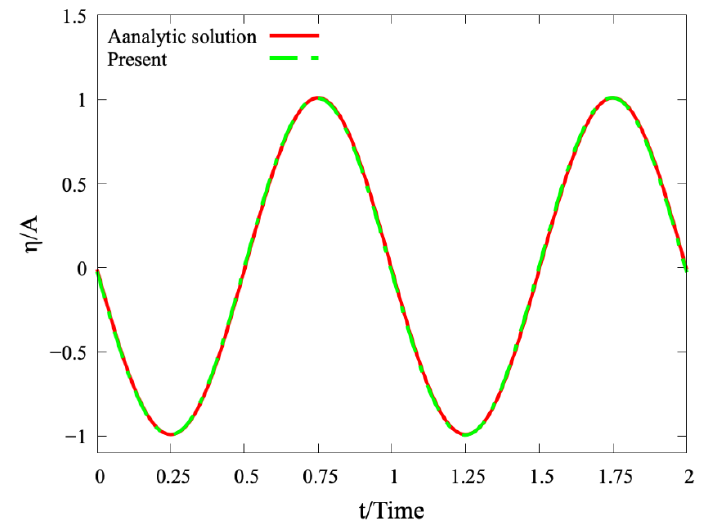
Figure 3. Wave elevation of regular wave.